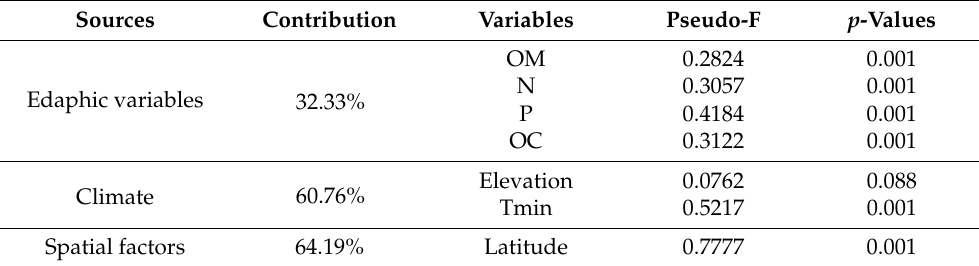
Figure 5. Non − metric multidimensional scaling (NMDS) ordination graph with fitted explanatory variables based on dissimilarities calculated using the Euclidean distance of sporocarp composition from plots in the two forest types ( A ) and by study sites ( B ), with rainfall displayed as isolines (fitted LOESS model R2 = 0.86). Arrows represent the environmental variables that were most significantly ( p < 0.005) related to ordination. The five ellipses indicate the plots in the five study areas (Msuba, Menagesha Suba; WG, Wondo Genet). Explanatory variables are shown in blue: OM, organic matter; Tmin, minimum daily temperature; N, total nitrogen; P, available phosphorus; OC, organic carbon. Table 3. Significance of explanatory variables for sporocarp composition in the two forest types. The numbers in bold indicate a highly significant effect of environmental variables ( p <